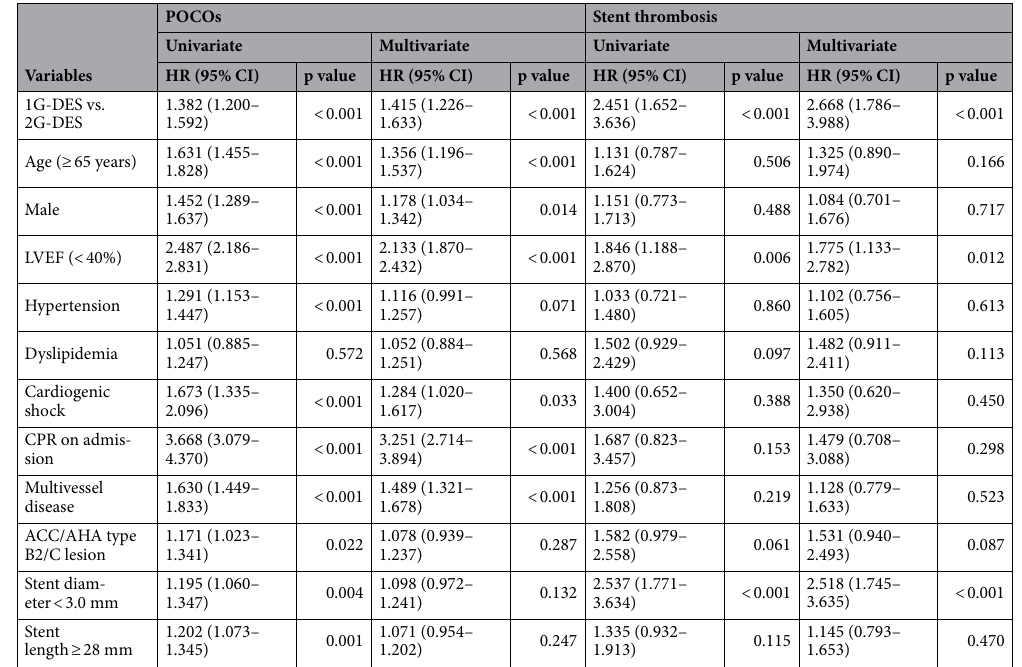
Table 4. Independent predictors for POCOs and stent thrombosis at 2 years. 1G first-generation, 2G second- generation, DES drug-eluting stent, POCOs patient-oriented composite outcomes, HR hazard ratio, LVEF left ventricular ejection fraction, CPR cardiopulmonary resuscitation, ACC/AHA American College of Cardiology/ American Heart Association.